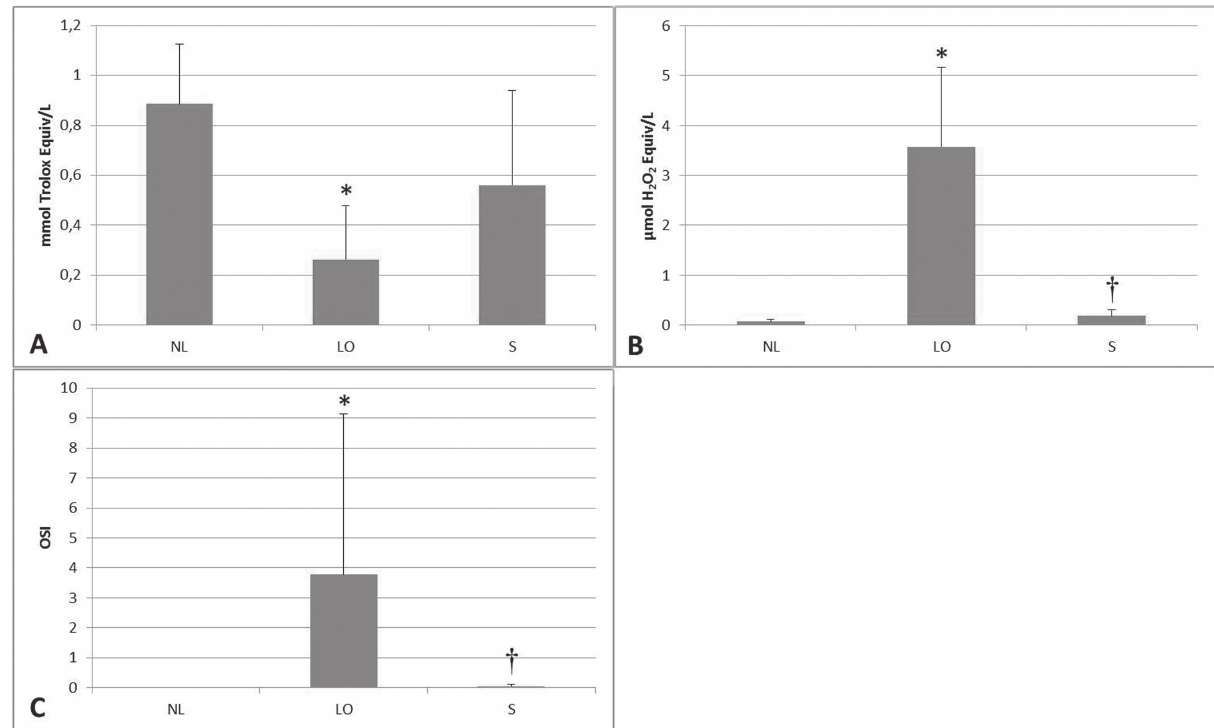
NL=non-ligated; LO=ligature only; S=ligature and treated with Figure 6 - A- Total antioxidant status (TAS) in NL, LO, and S groups; B- Total oxidant status (TOS) in NL, LO, and S groups; C- the oxidative stress index (OSI) levels in NL, LO, and S groups. *Significant difference compared to NL group. †Significant difference compared to LO